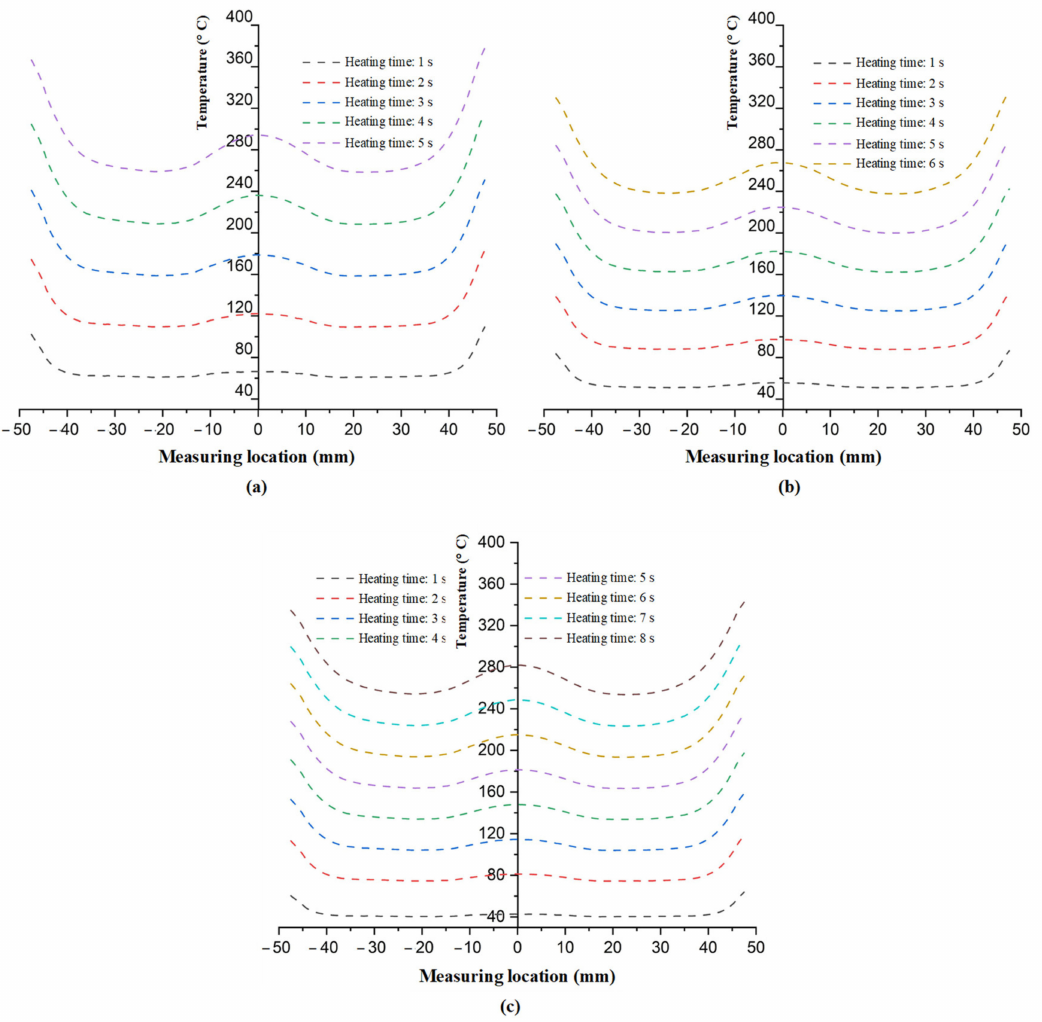
Figure 11. Simulation result of temperature distribution of line L with the gap (G) of ( a ) 5; ( b ) 10; and ( c ) 15 mm at the end of heating